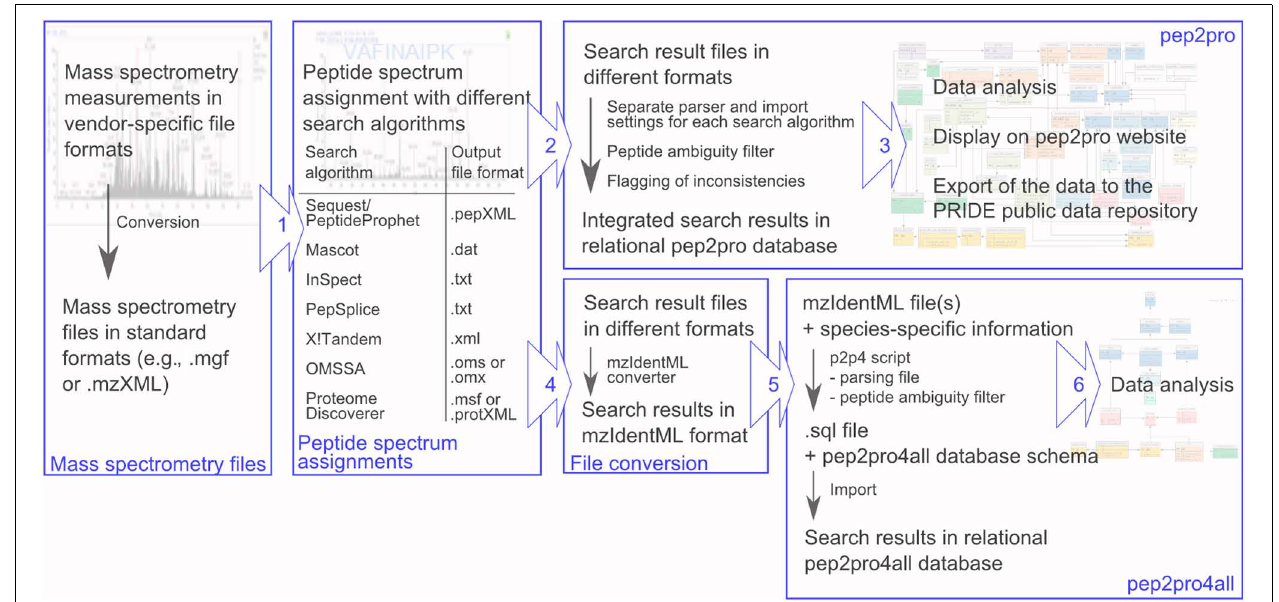
result files into pep2pro4all, they are first converted into mzIdentML standard format using a mzIdentML converter. (5)The p2p4a script then parses